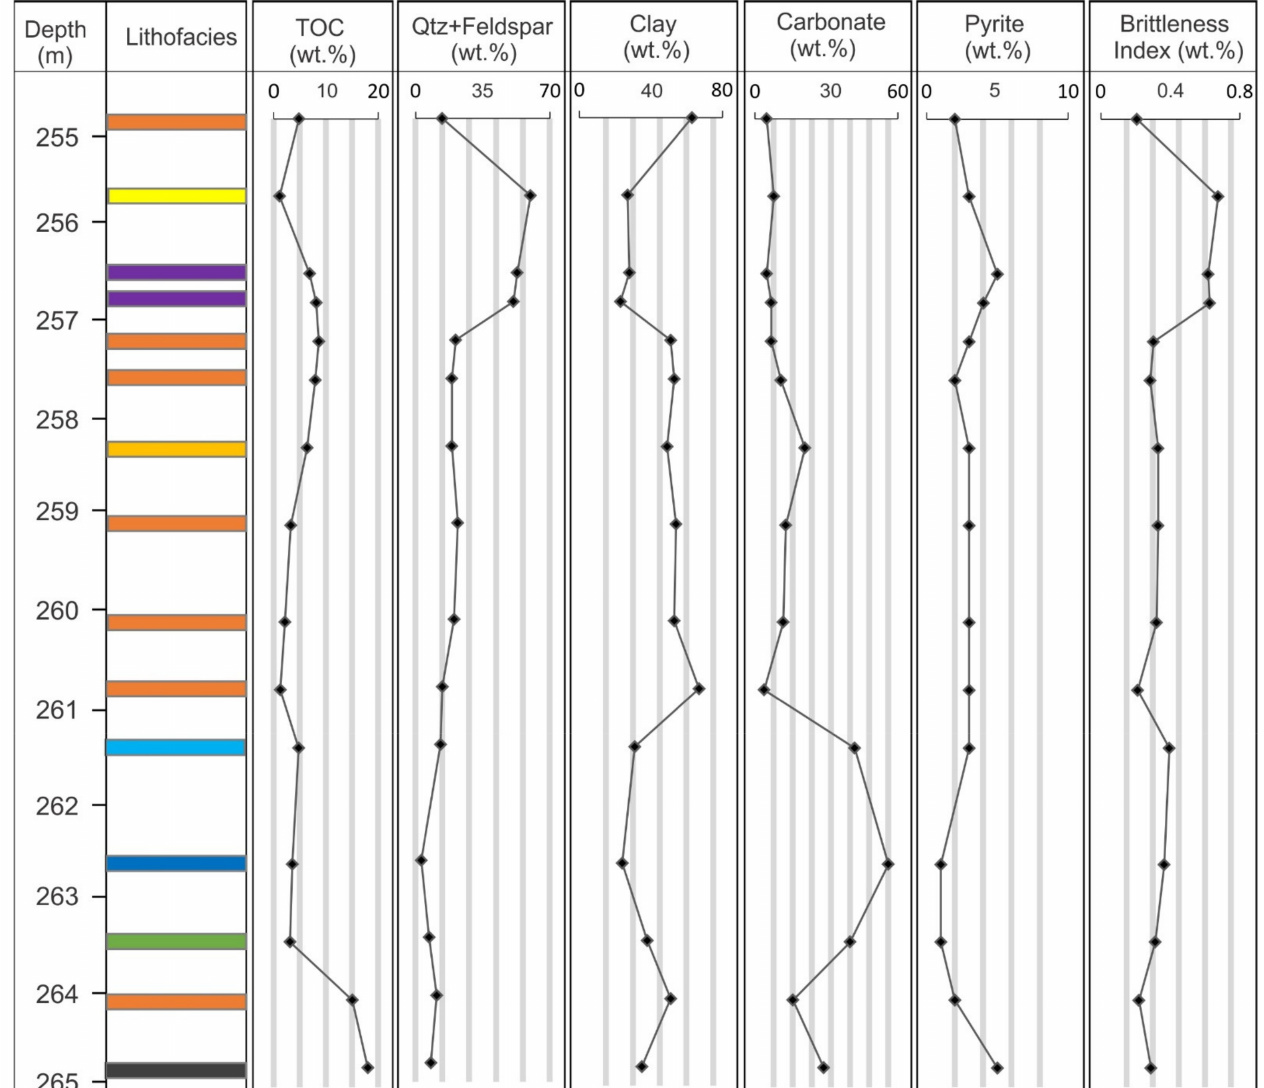
Figure 4. Total organic carbon (TOC), mineralogical (quartz, feldspar, clay, carbonate, and pyrite) and brittleness index (BI) profiles of the lithofacies in the studied